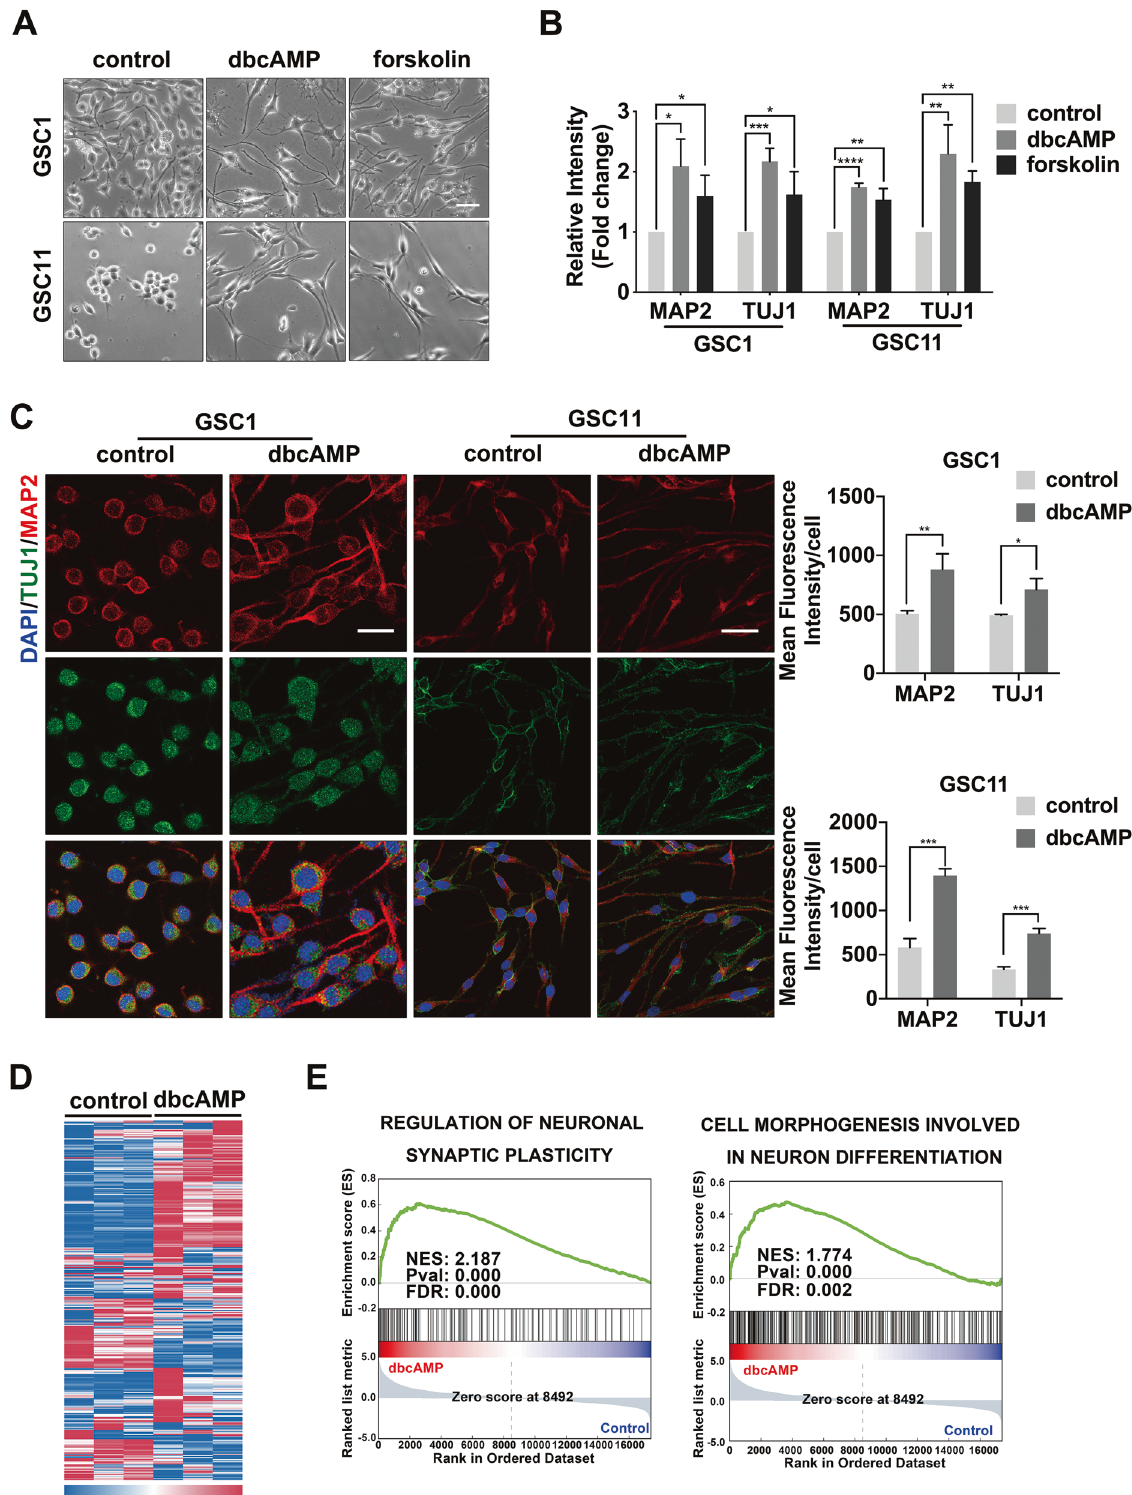
Fig. 1 cAMP induces neuronal differentiation in GSCs. A Phase-contrast image of GSC1 and GSC11 cells before and after treatment with dbcAMP and forskolin for 72 h (scale bar, 100 μ m). B Quanti fi cation of MAP2 and TUJ1 in GSCs treated with dbcAMP and forskolin by fl ow cytometry. C Immuno fl uorescence staining of MAP2 (red) and TUJ1 (green) in GSCs before and after incubation with dbcAMP (left) and quanti fi cation of fl uorescence intensity (right) (scale bar, 50 μ m). D Heat map of differentially expressed genes between GSCs treated with and without dbcAMP. E GSEA analysis using the mRNA sequencing data. (Data are shown as the mean ± SD. N.S., not signi fi cant; *, p < 0.05; **, p < 0.01; ***, p < 0.001; ****, p < 0.0001).